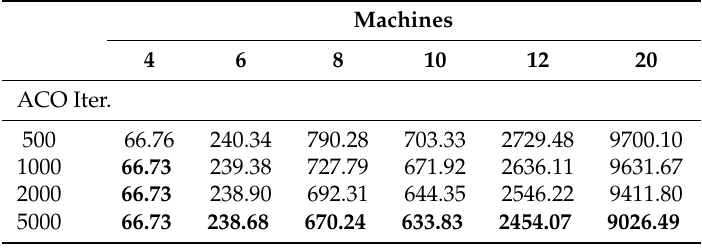
Table A1. The results of experiments conducted to determine which set of parameter values lead to the best solutions for MS. For each parameter, the results are averaged across the results obtained by the settings of all other